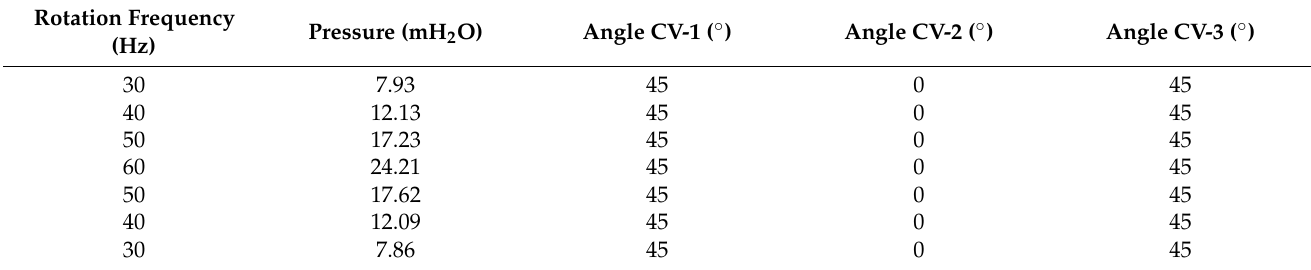
Table 2. Parameters used for the test for choosing of the soft